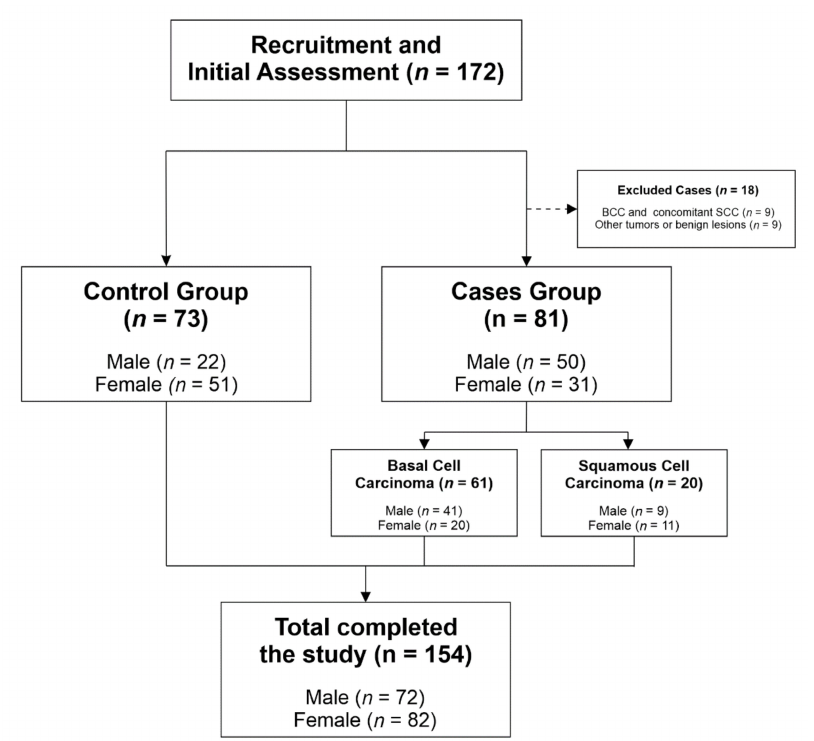
Figure 1. Participant selection